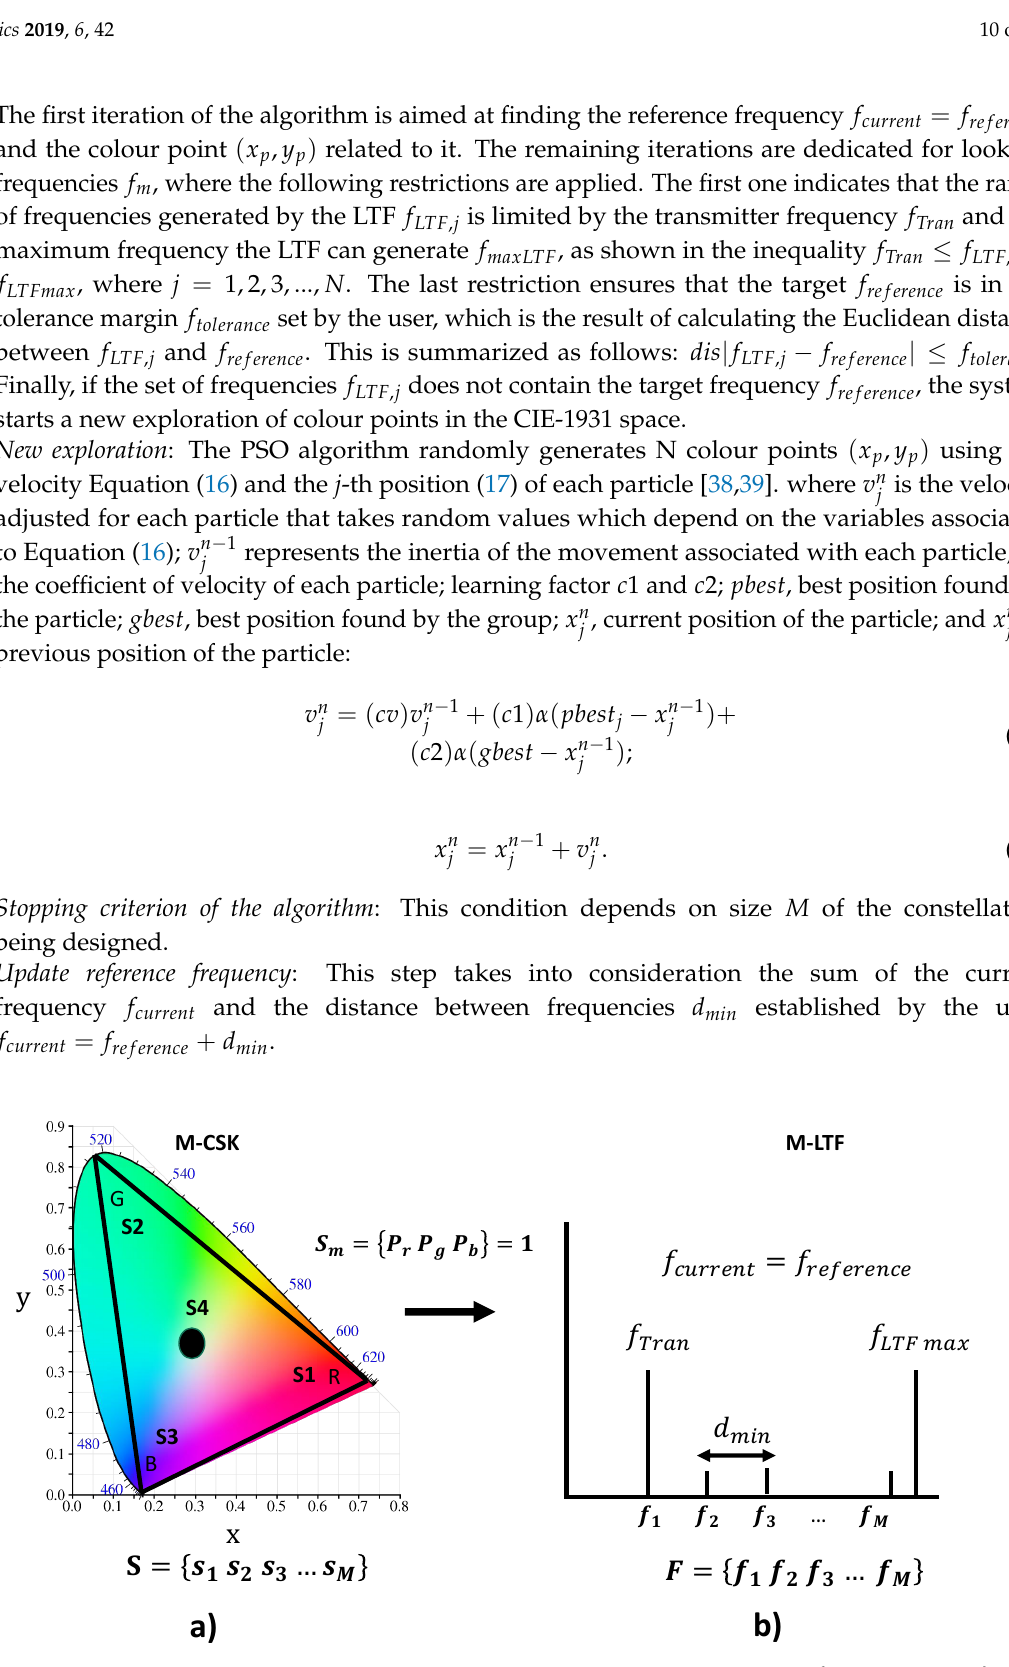
Figure 7. General scheme of the M-CSK-LTF system. ( a ) M-CSK constellation S = { S 1 , S 2 , S 3 ,..., S M } and ( b ) Frequencies generated in the LTF F = { f 1 , f 2 , f 3 ,..., f M }